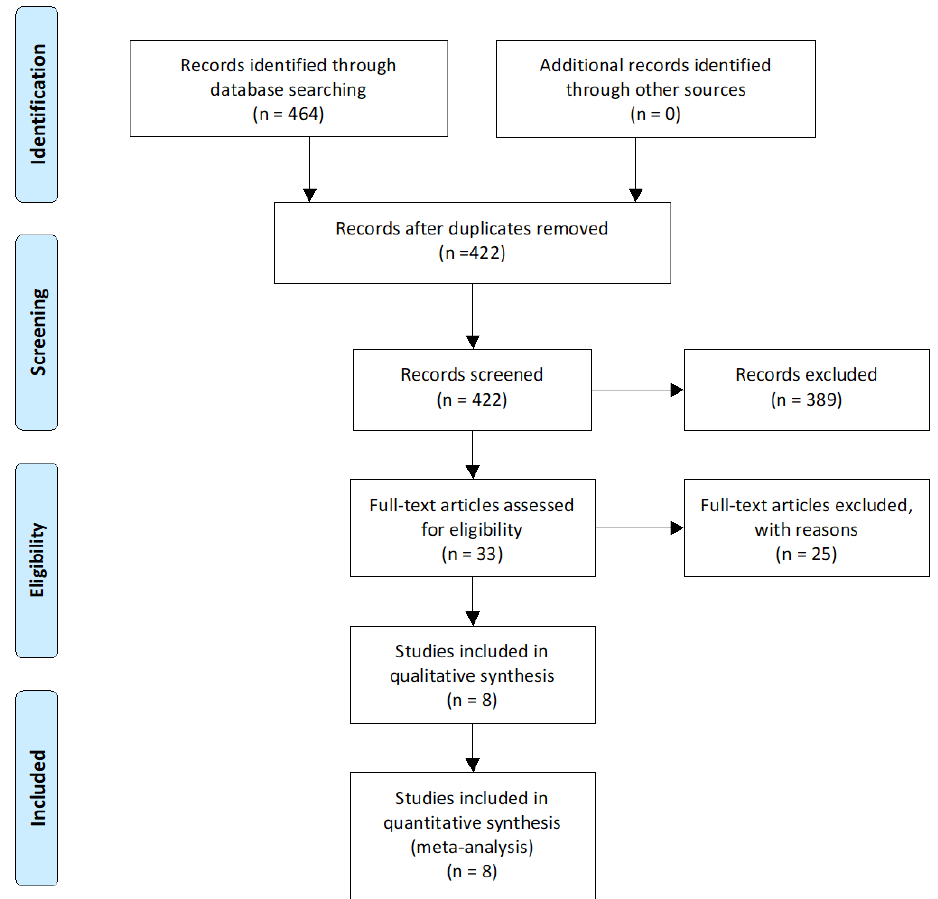
Figure A1. Systematic review summary table [14].